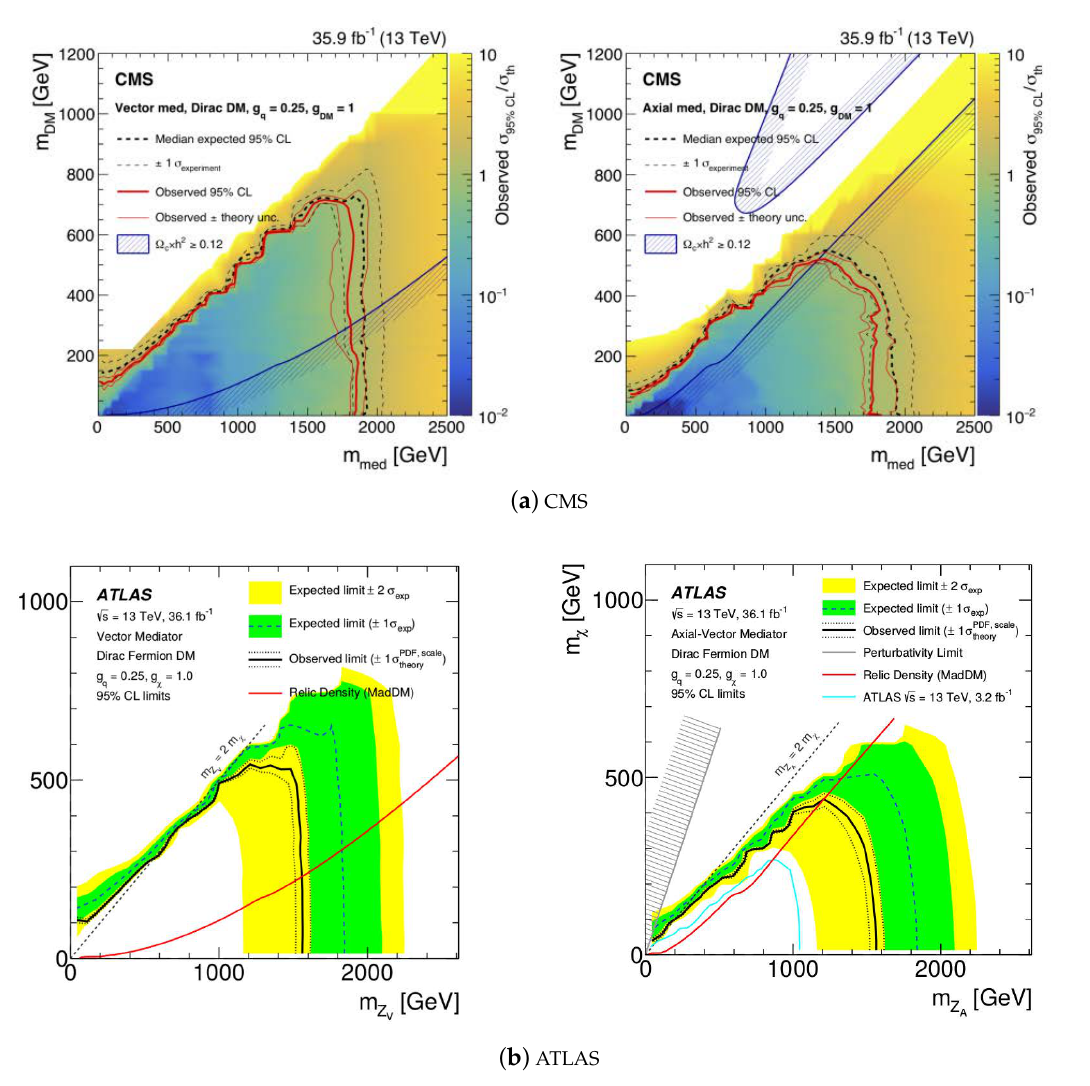
Figure 3. Exclusion limits for the CMS [7] ( a ) and ATLAS [8] ( b ) mono-jet analyses. On the left-side plots, results are interpreted in terms of the vector mediator, and on the right-side, plots in terms of the axial-vector mediator. In both cases, the DM particles are considered as Dirac fermions. The coupling of the mediator to quarks (g q ) is set to 0.25, and the coupling of the mediator to DM (g DM or g χ ) is fixed to